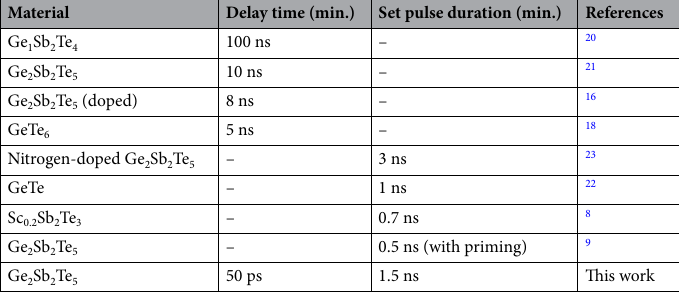
Table 1. Comparison of present work with existing literature.